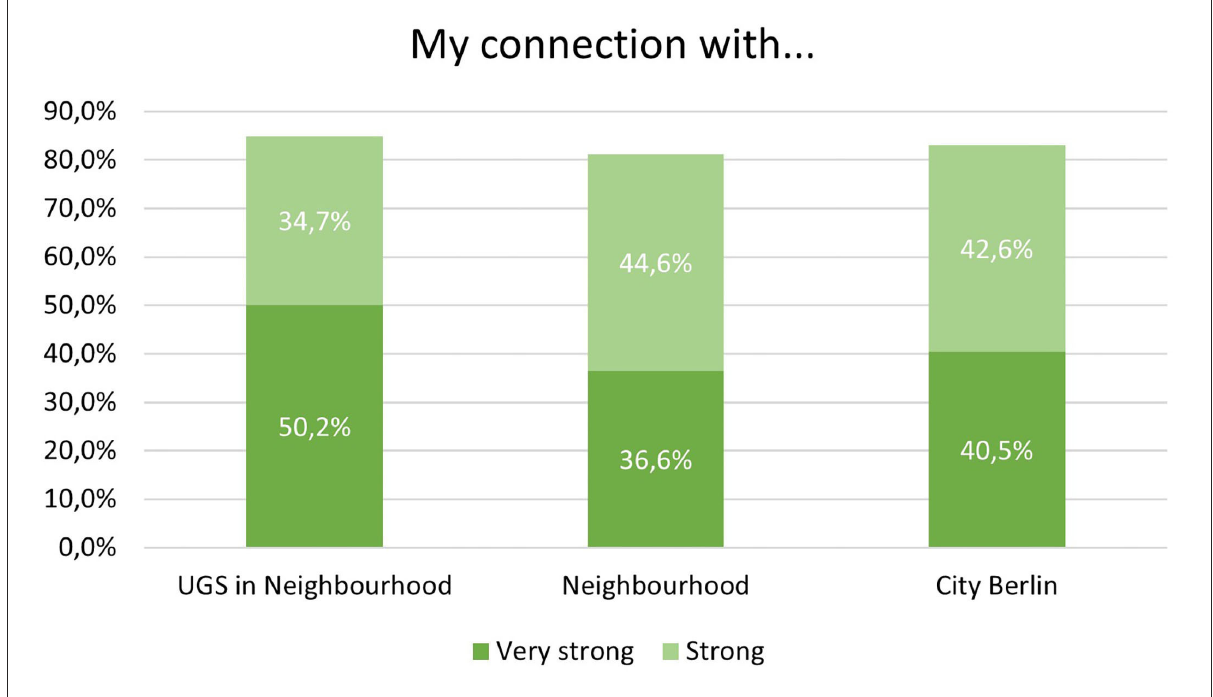
FIGURE3 Connectedness the place of residency, measured on three different levels.